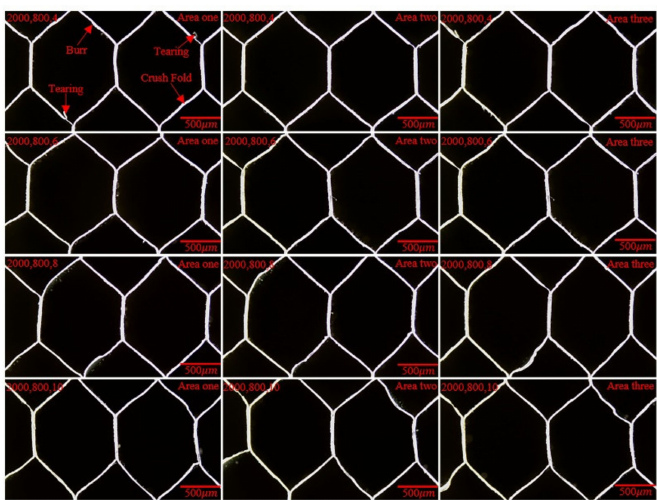
Figure 13. The effect of tool cutting width on surface morphology.